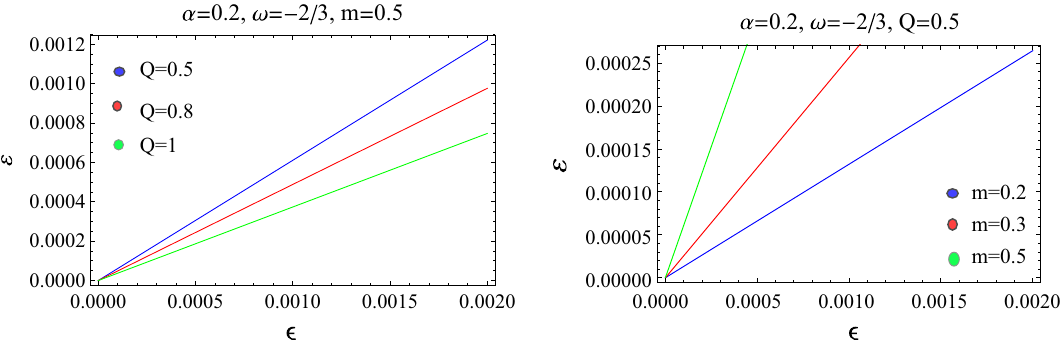
Fig. 9 Behavior of the energy within the shell verses thickness of the shell with β = 0 . 5 and b 0 =